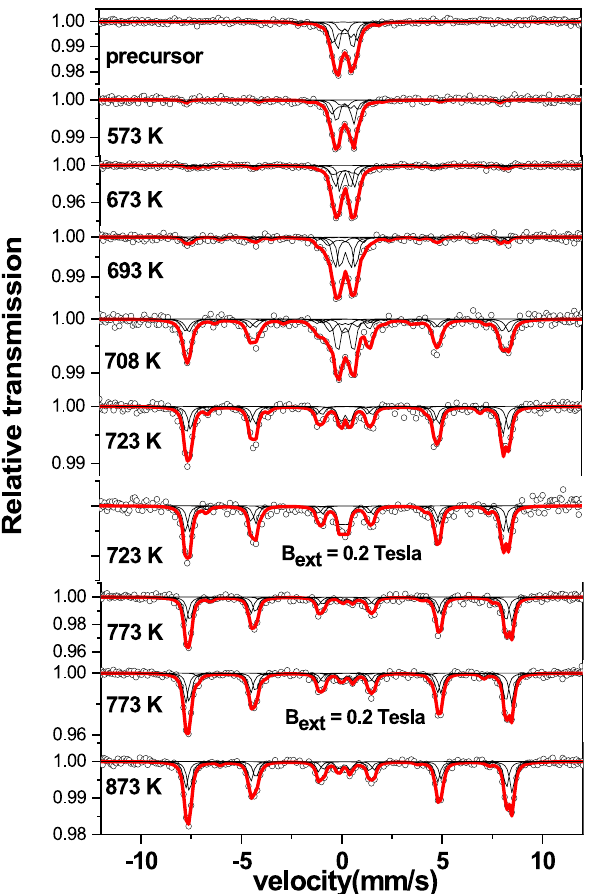
Figure 5. Mössbauer spectra obtained at 300 K in the pristine precursor gel and subsequent to calcination at different temperatures for 2 h as